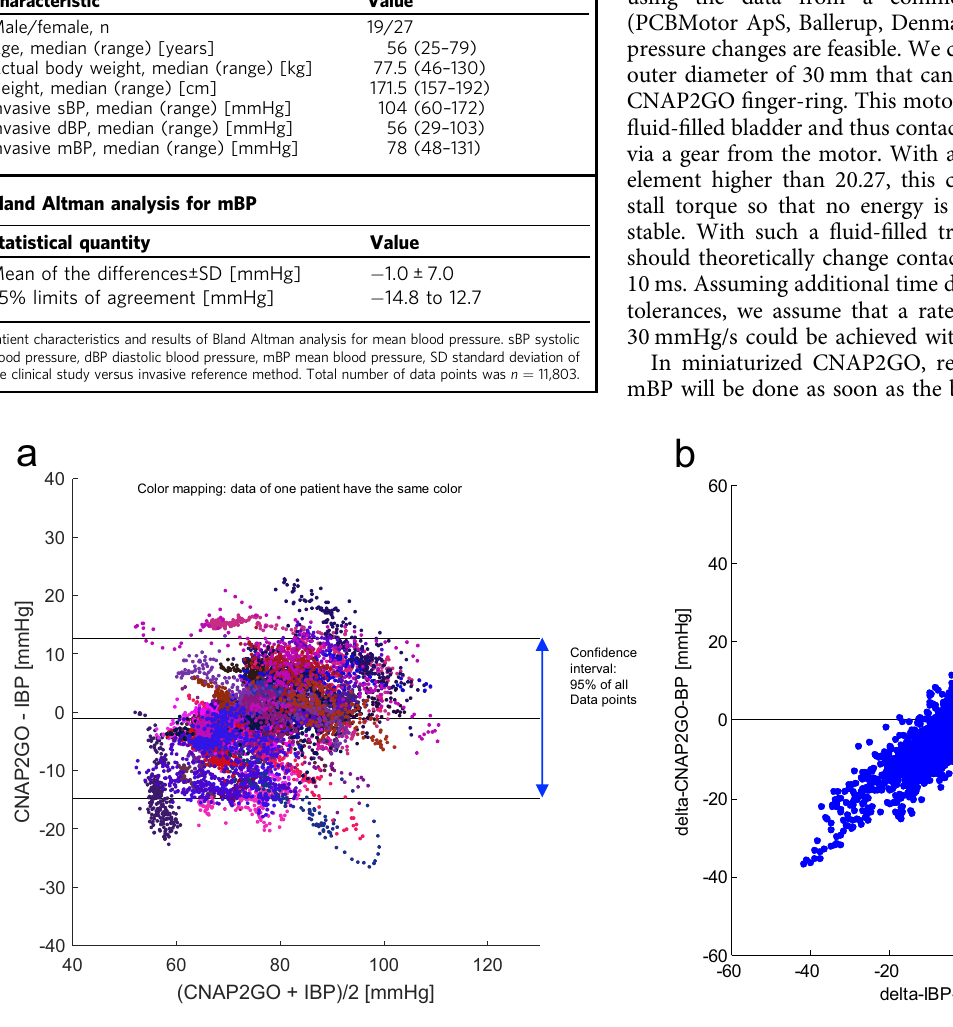
Fig. 6 Results from clinical study. a Bland Altman plot for mean blood pressure. Same-color points stem from the same patient. The plot includes indication of bias together with 95% limits of agreement which de fi ne the range in which 95% of all data points are expected to lie. Total number of data points was n = 11,803. b Concordance plot of spontaneous changes in mBP found within 5 min by invasive blood pressure (IBP) and CNAP2GO (i.e., delta- IBP-BP and delta-CNAP2GO-BP, respectively). Total number of changes assessed was n = 10,390.